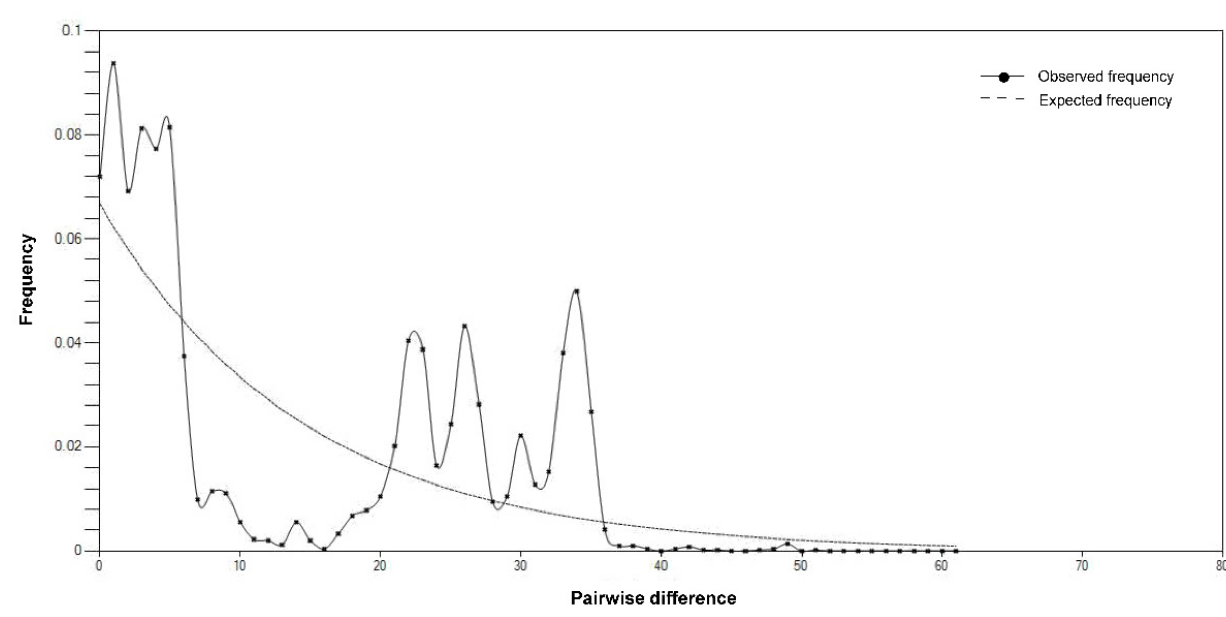
Figure 5. Observed and expected distributions of pair-wise sequence differences in mitochondrial concatenated sequences of Cyt b and COI of Schizothorax kozlovi in the upper Yangtze River.